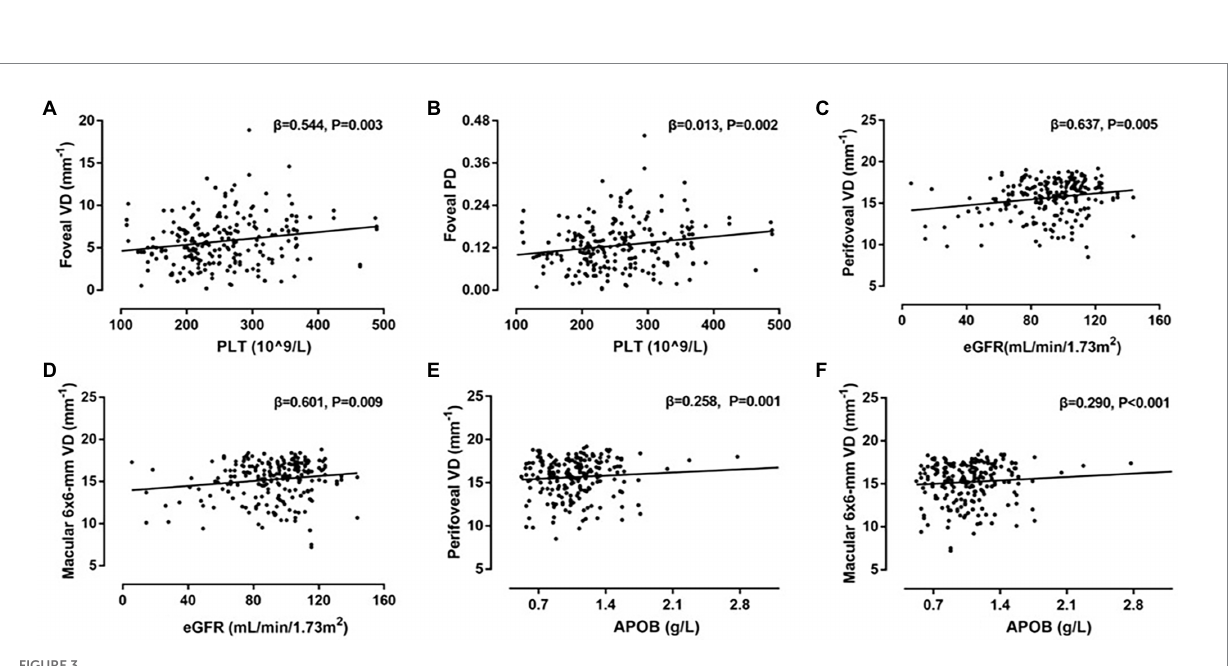
FIGURE 3 Correlations between systemic risk factors and optical coherence tomography angiography (OCTA) parameters. (A) Scatter plot between platelets (PLT) and vessel density (VD) in foveal; (B) scatter plot between PLT and perfusion density (PD) in foveal; (C) scatter plot between eGFR and VD in perifoveal; (D) scatter plot between eGFR and VD in macular 6 × 6-mm; (E) scatter plot between APOB and VD in perifoveal; (F) Scatter plot between apolipoprotein B (APOB) and VD in macular 6 ×